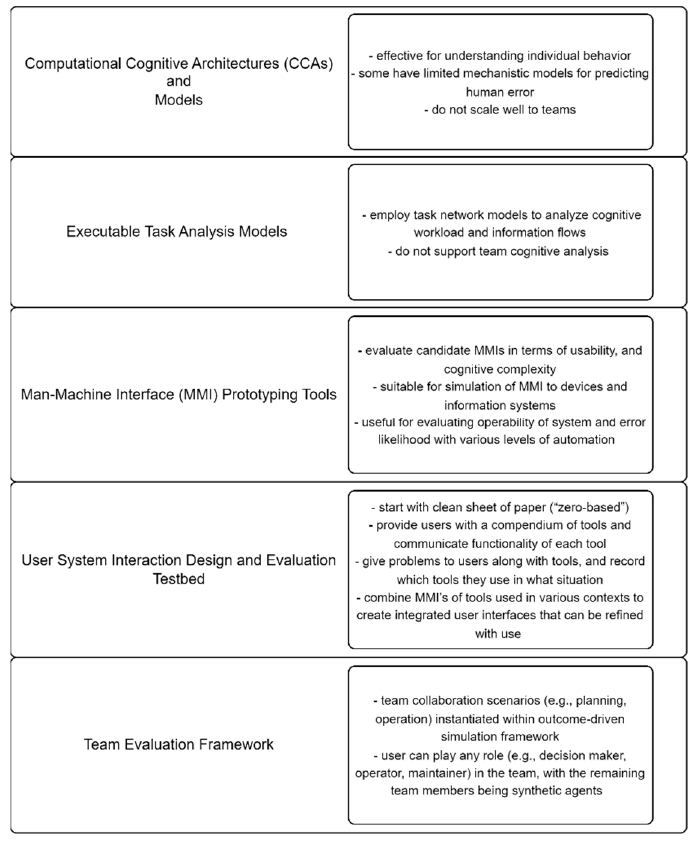
Figure 3. Cognitive Engineering Techniques based on [18,32].